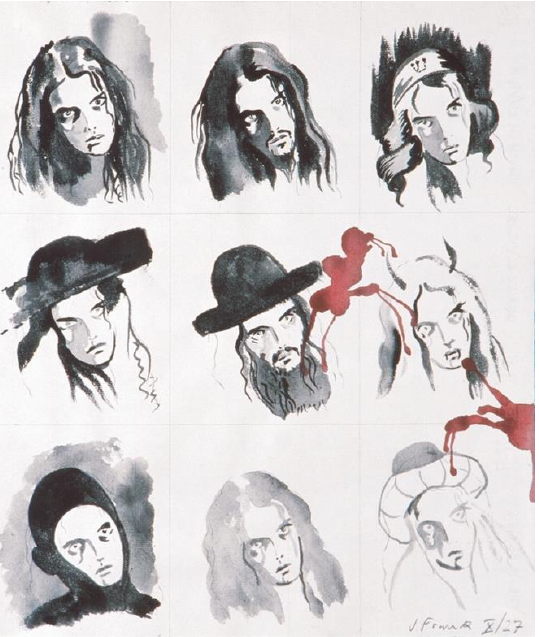
Figure 18. Justine Frank, from “The Stained Portfolio”, 1927–1928, gouache on paper, 33 × 38 cm. Courtesy of the artist.